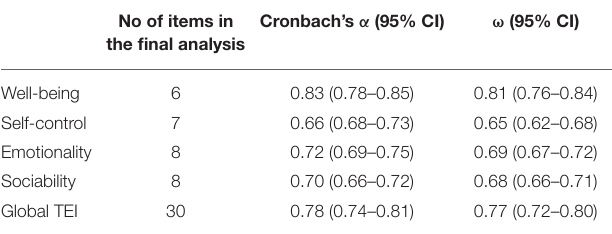
TABLE 2 | Reliability estimates of the TEI and its